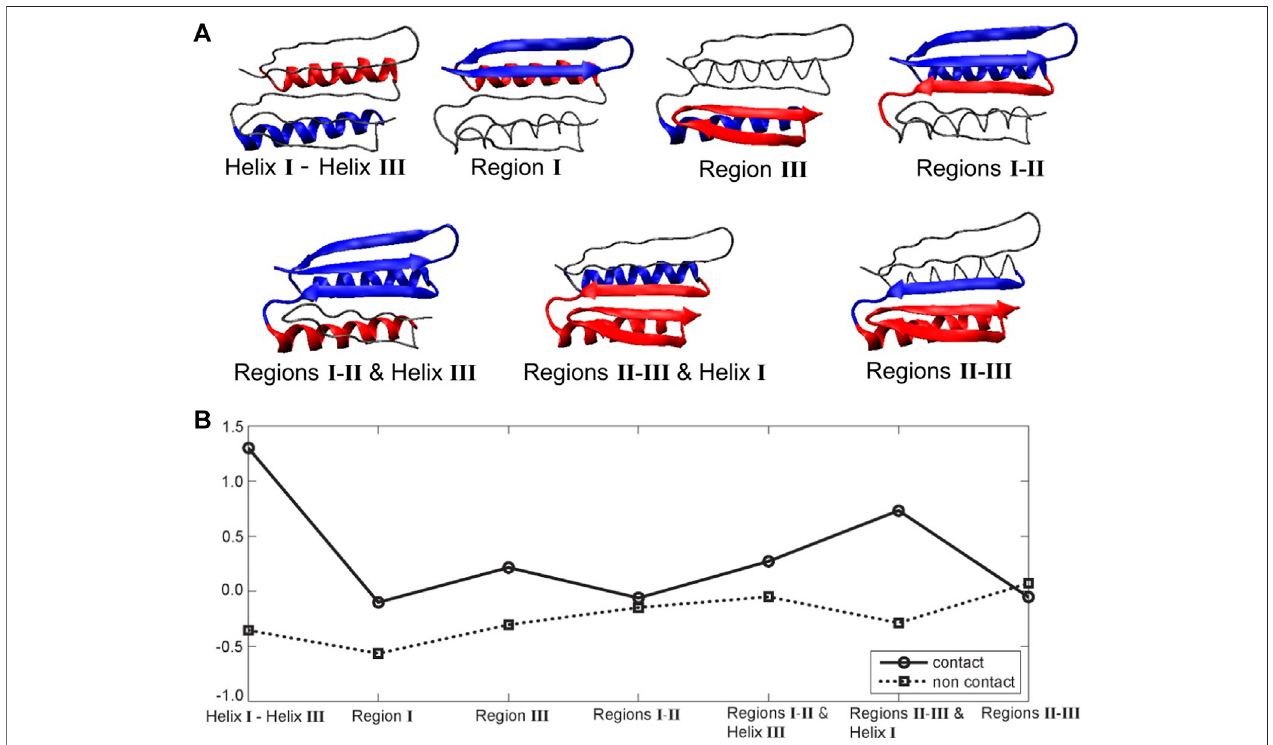
FIGURE5| Top7hydropathyanalysis. (A) Structuralsub-segments(thebackboneisrepresentedasathinline).Eachsegmentisdividedintotwoconstituentparts (blue and red). The partitioning was performed heuristically to account for the known functionally important regions that encompass secondary structure elements. (B) Corresponding Kyte and Doolittle hydropathy plot (Kyte and Doolittle, 2003; residue speci fi c hydropathy scores averaged over the constituent parts; see Methods section). Negative and positive values indicate the degree of hydrophilicity and hydrophobicity, respectively. Average Black and Mould scores (Black and Mould, 1991; based on non-negative scores that measure only hydrophobic propensity) were also computed but are not shown here because they closely resemble the Kyte and Doolittle contact plot.